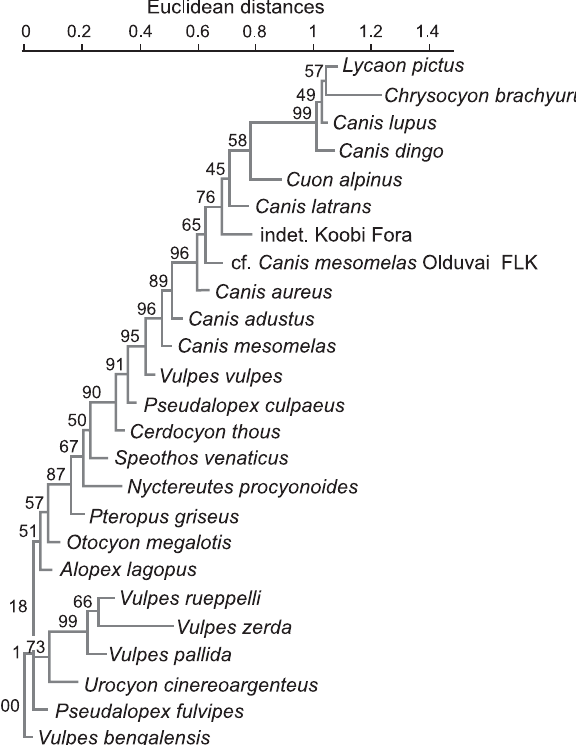
Fig. 5. Neighbour-joining cluster analysis performed using Euclidean dis- tances extracted from proximal measurements. Bootstrap values show the support for each internal